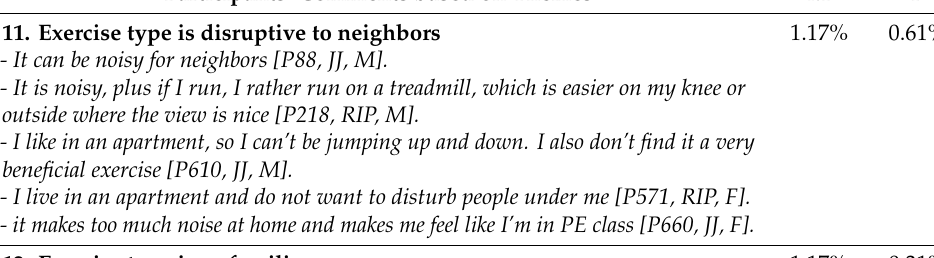
Table A2. Cont . Participants’ Comments based on